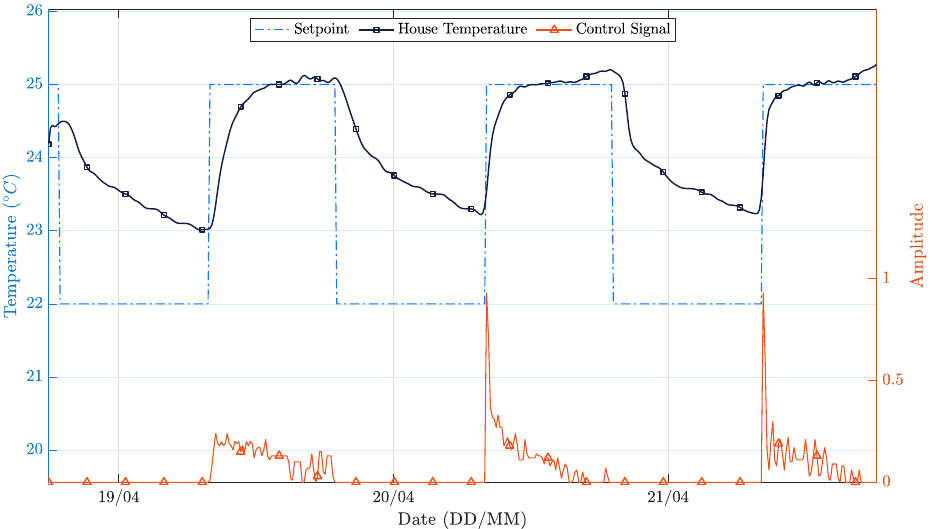
Figure 12. House temperature variation during test time PP [5].